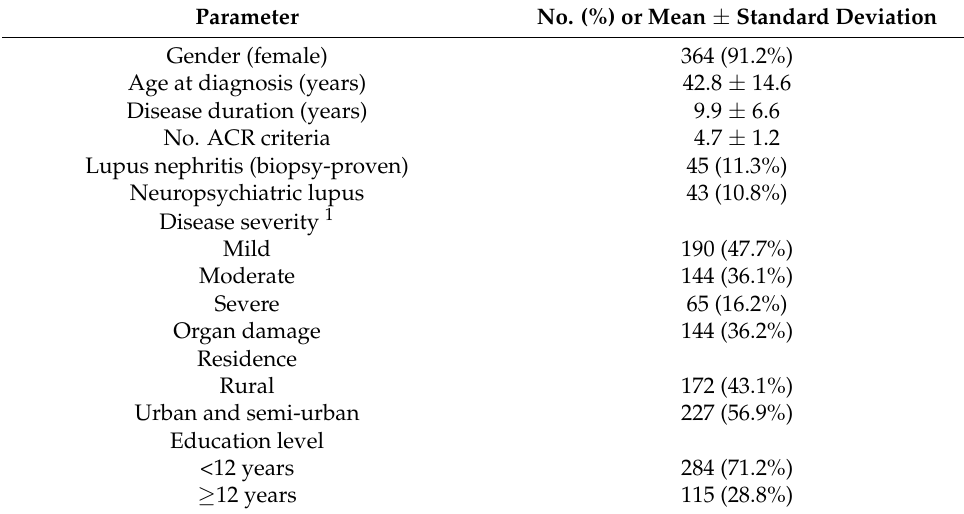
Table 1. Demographic and clinical characteristics of Systemic Lupus Erythematous (SLE) patients ( n = 399) at the time of